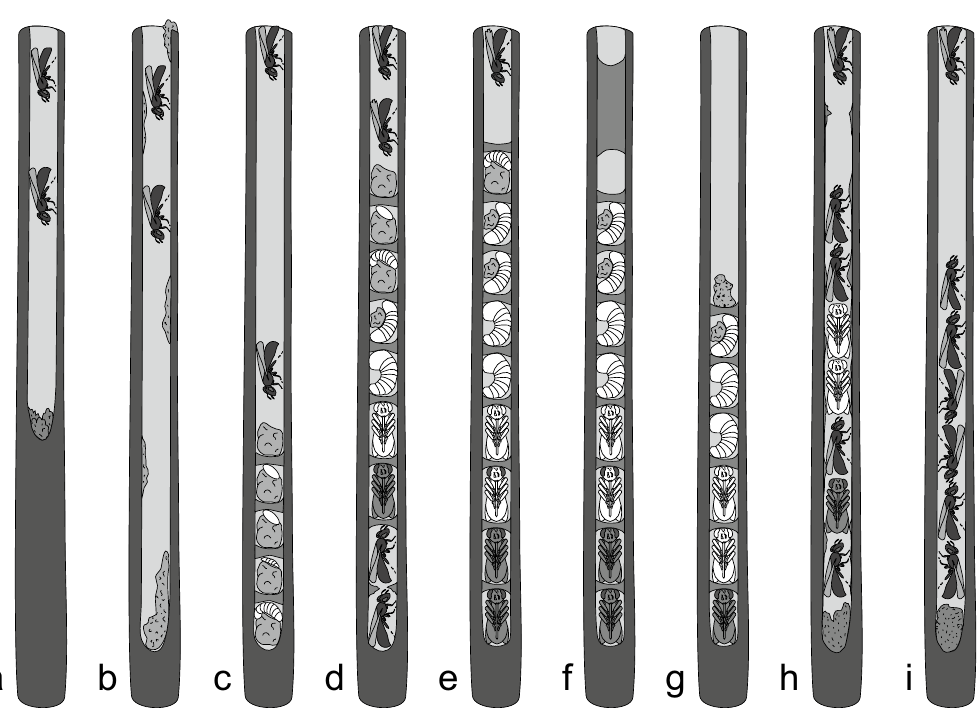
Figure 1. Nesting cycle of C. nigrolabiata . ( a ) newly excavated nests—burrow which contains only adult(s) and sometimes fillings. ( b ) discarded nest—burrow where previous nest was discarded, and there are pollen remnants on the walls ( c ) active brood nest—nest in phase brood cell provisioning ( d ) large active brood nest, where egg is present at the top, but young adults already developed at the bottom of nest ( f ) guarded full brood nest—mother guards this nest ( f ) plugged full brood nest—nest is unguarded and closed by a thick filling plug ( g ) orphaned full brood nest—last brood cell partition is thin and above it is commonly pollen from incompletely provisioned brood cell ( h ) full-mature brood nest—this nest contains juveniles, young adults, and sometimes mother ( i ) mature brood nest—this nest contains young adults and sometimes mother. All these figures are hypothetical examples, they are not based on concrete dissected